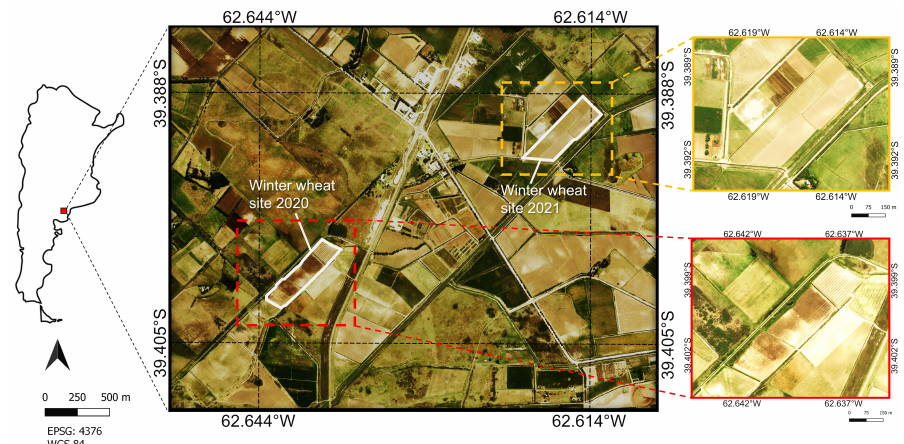
Figure 1. Overview of BVCR test sites (ROI) for the winter wheat campaigns of the years 2020 and 2021. The red and orange dotted rectangles delimit the MOGP subsets analyzed in Section 3.3. Reference system: WGS84 (EPSG 4326). (For interpretation of the references to color in this figure legend, the reader is referred to the Web version of this